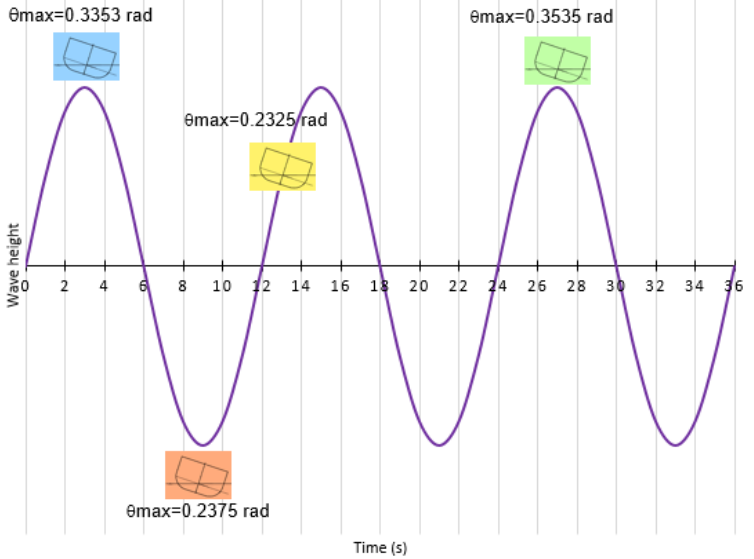
Figure 9. Maximum rolling angles and the time (t) when they are reached under the influence of